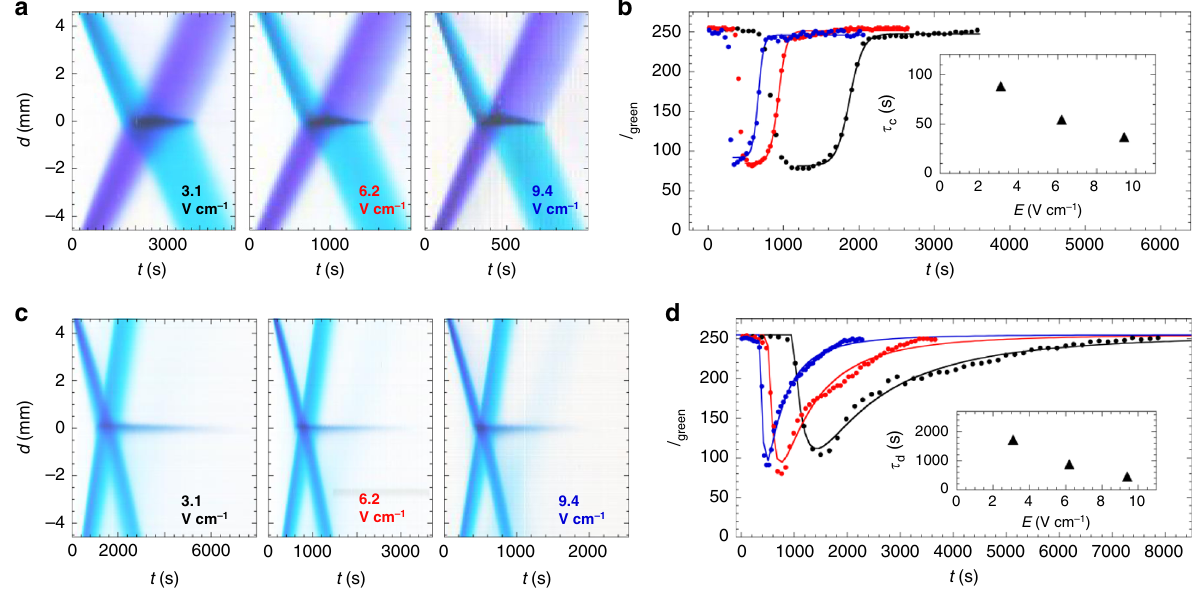
Fig. 6 Dependence of complexing and decomplexing kinetics on the applied electric fi eld strength using BCGE. Conditions: same as in Fig. 3, except E . a Background-subtracted space – time plots of band collisions between MG( + 2 e ) and BPB( − 2 e ) at fi eld strengths E (V cm − 1 ) of 3.1 (black text, left); 6.2 (red text, middle); and 9.4 (blue text, right). The range of times shown for 6.2 and 9.4 V cm − 1 have been reduced by factors of 2× and 3×, respectively, yielding similar X-patterns to that shown for 3.1 V cm − 1 . b Intensity pro fi les showing decomplexing kinetics, extracted from part a using the green color channel intensity I green taken across d = 0 mm, where the stationary product band appears, as a function of time t for different E (points color coded as in part a ); lines are fi ts of long-time data using Fermi-like functions (see Supplementary Table 2). Inset: time constant τ c ( E ) obtained from the fi t decreases as a function of E . c , d Same as parts a and b , but instead for dyes MB( + e ) and BB( − 2 e ). In part d , I green ( t ) are fi t using a modi fi ed log-normal function describing the optical absorption of the stationary band at d = 0 (lines, see Supplementary Table 3). The x -direction points downward in parts a and c . Inset: τ d from the fi ts decreases for larger E . Source data are provided as a Source Data fi